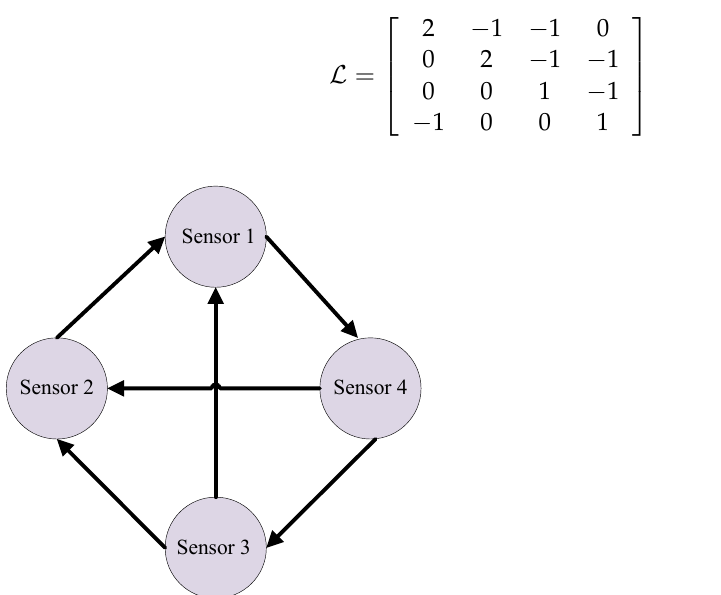
Figure 2. The topology of sensor